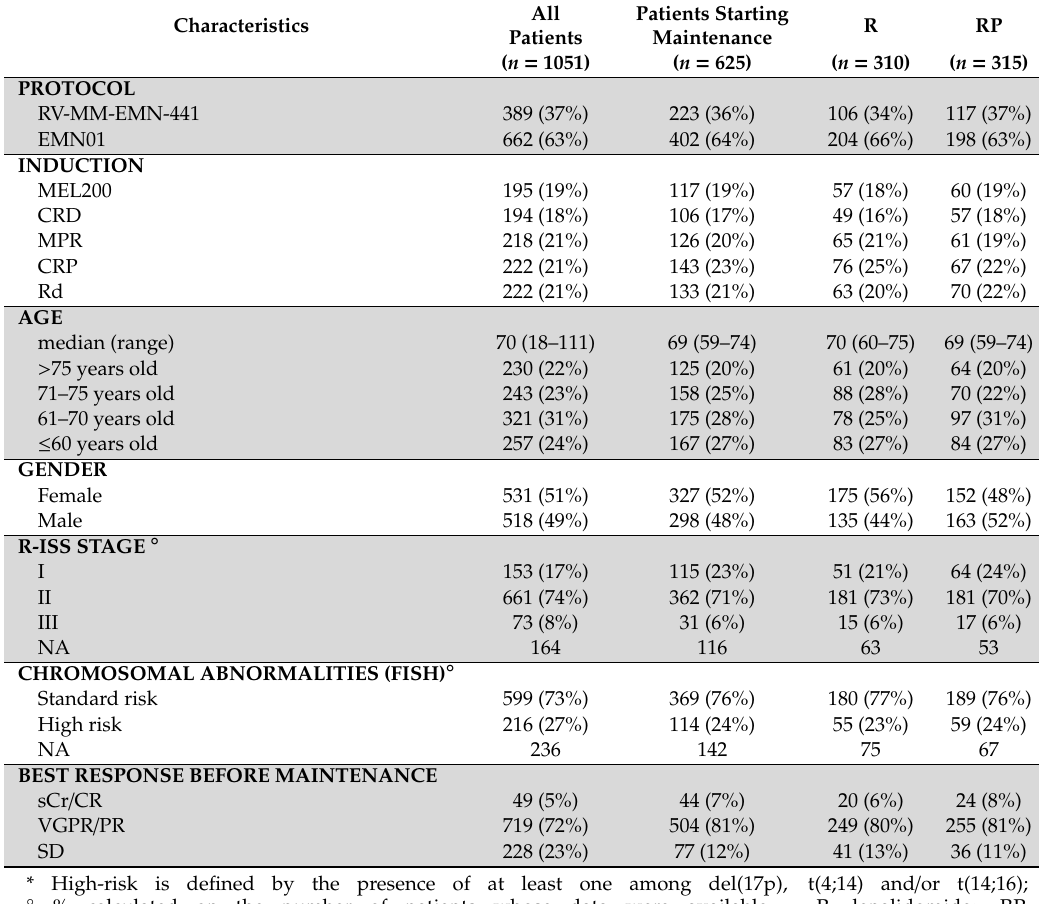
Table 1. Main patient